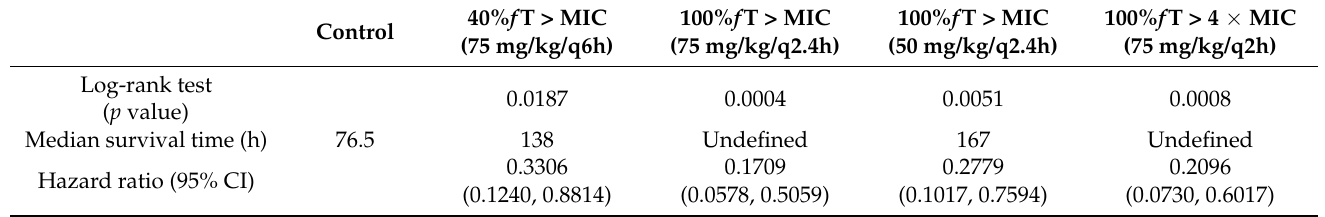
Table 3. The statistical results of survival outcomes between different meropenem treatment groups in sepsis rat model.